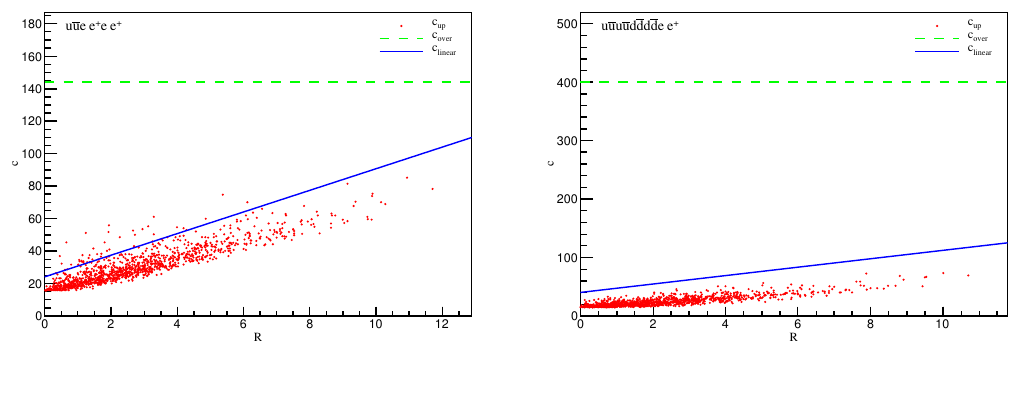
Figure 3 . The correlation between R and the upper limit of the branching kernel. To approximately determine these upper limits, shower emissions are sampled from events generated uniformly with the RAMBO algorithm [43]. The value of c is the required value of the overestimate constant up c found by evaluating the branching kernel for every sampled emission. The dashed green line corresponds with the absolute overestimate given by eq. (2.36). The solid blue line represents the incomplete overestimate given by eq.